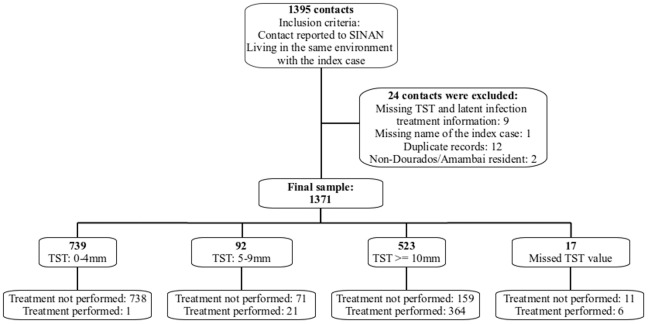
Flowchart illustrating the recruitment of tuberculosis contacts.